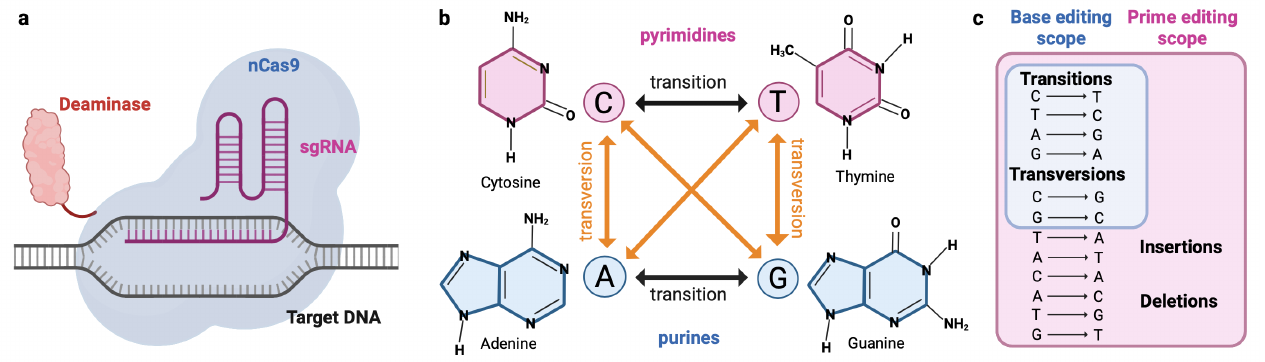
Figure 1. ( a ) The base editing system consists of a single guide RNA (sgRNA), a Cas9 Nickase (nCas9) and a deaminase enzyme (adenin deaminase for ABEs and cytosine deaminase for CBEs). ( b ) Graphical overview of the 12 different base pair substitutions. ( c ) Editing scope of the base editing (blue) and prime editing (pink)